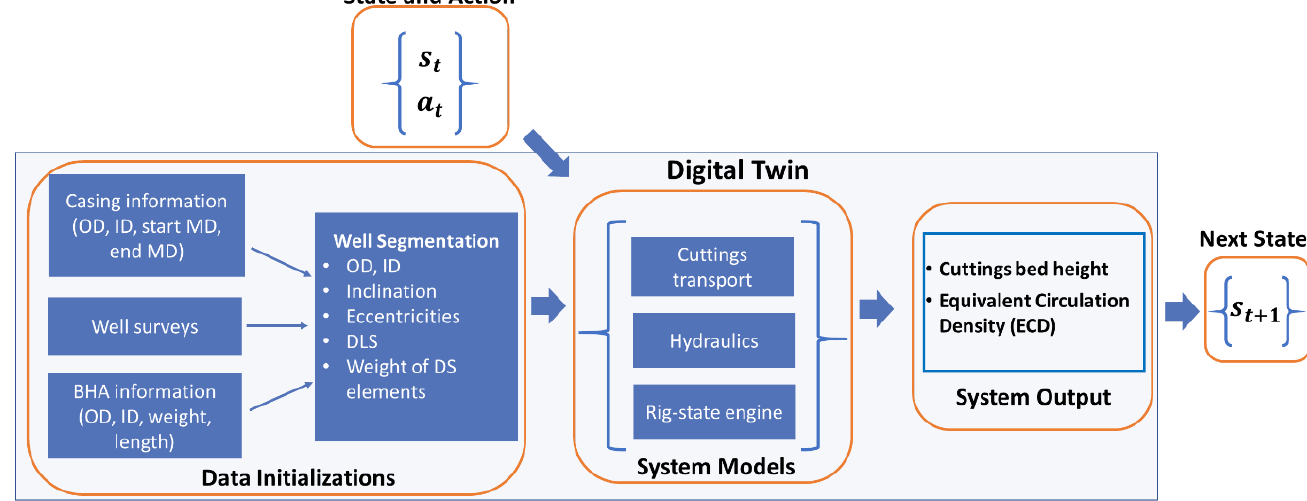
Figure 8. Application of the hole cleaning digital twin for forward-simulation.